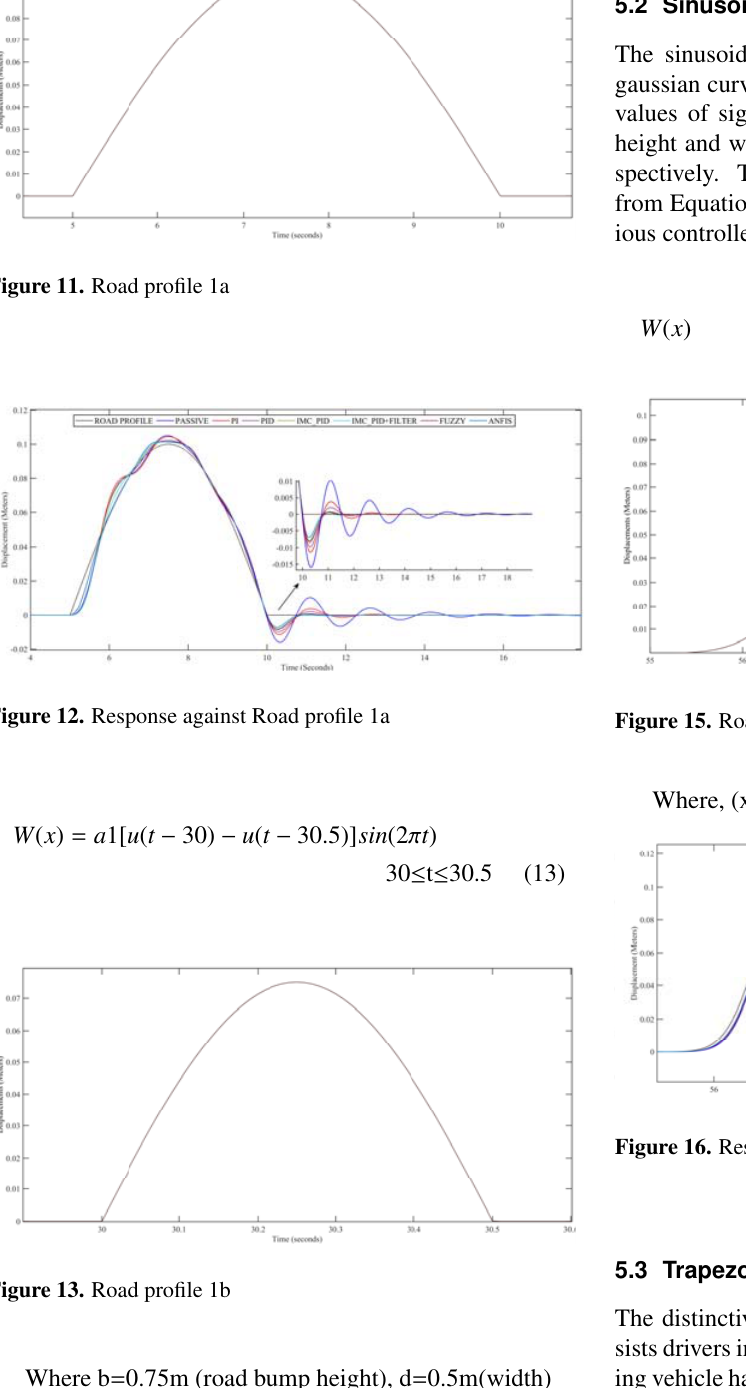
Where b = 0.75m (road bump height), d = 0.5m(width)